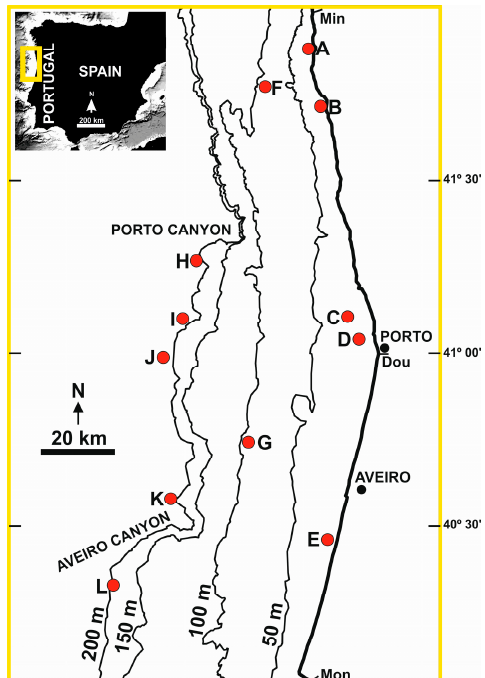
Figure 10. Location of the samples subjected to electron microprobe analysis (red dots from A–L). Min: Minho River; Dou: Douro River; Mon: Mondego River (adapted from [10]).